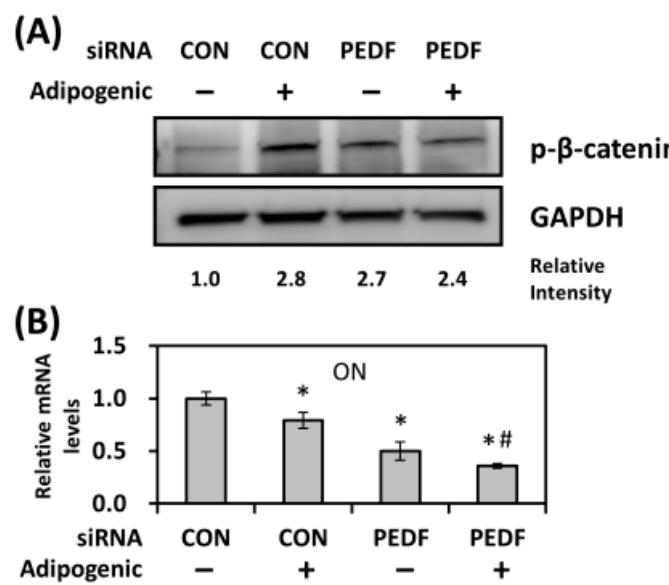
Figure 6. PEDF knockdown induces β -catenin phosphorylation during adipogenesis. ( A ) Rat AdSCs were transfected with control or PEDF siRNA, followed by adipogenic differentiation induction for 24 hr. Whole-cell extracts were immunoblotted for phospho- β -catenin. Relative intensity was compared with control siRNA transfected, undifferentiated cells, as determined by densitometry normalized to GAPDH. ( B ) As in ( A ), control and PEDF siRNA-transfected AdSCs were incubated with adipogenic differentiation medium for 24 hr. Gene expression was analyzed using quantitative RT-PCR. * Statistically significant from the control transfected, vehicle-treated group at p < 0.05; # statistically significant compared with the PEDF siRNA transfected, vehicle-treated group at p < 0.05.